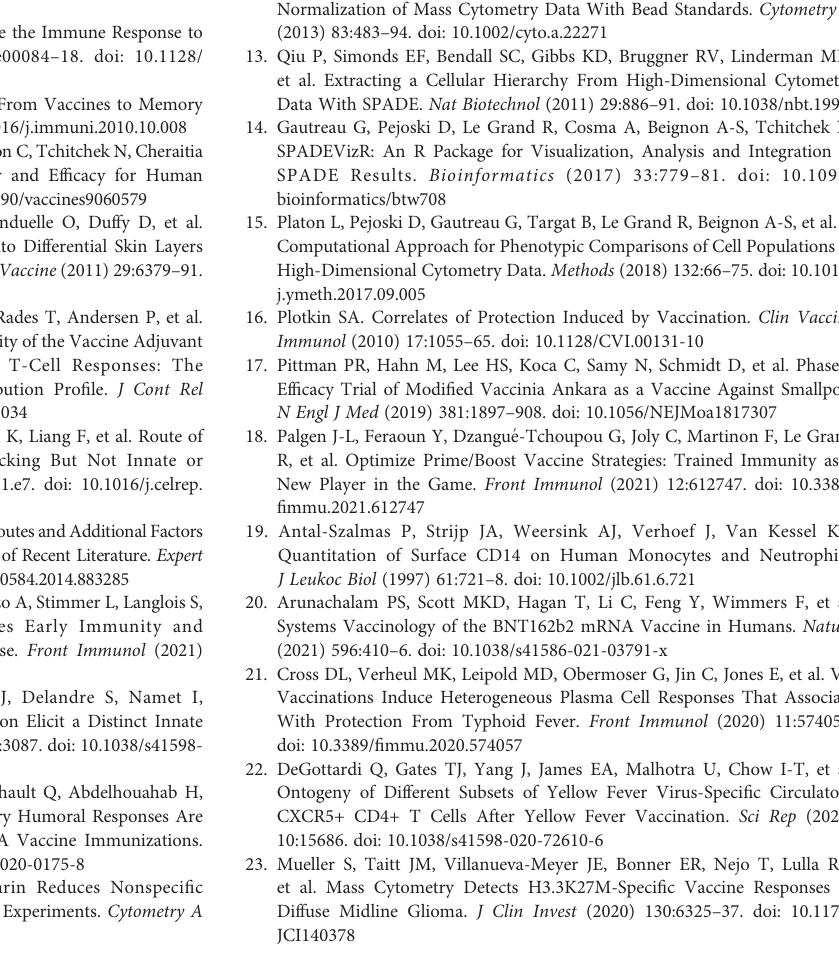
Supplementary Figure S1 | Control samples. The same fi xed and frozen control samples were stained and acquired with the samples from the vaccinated animals after exvivo restimulationwithamixtureofTLRligands. (A) Gatingstrategytode fi ne the CD66 high HLA-DR - , CD66 -/mid HLA-DR -, and CD66 -/mid HLADR + cell populations. The non-stimulated control sample for the fi rst staining/acquisition session is shown. (B) Comparison of the staining pro fi les using overlaid histograms. Supplementary Figure S2 | SPADE tree annotation. The topology of the SPADE tree is shown, with the color of each node of the SPADE tree representing the median expression of the indicated markers among all cells from the entire dataset with a scale adapted for each marker. This allowed the identi fi cation of the major blood cell populations, including granulocytes. The size of the node is not proportional to the number of cells it contains. Supplementary Figure S3 | Cytokine and chemokine expression pro fi les in blood after one or two ID MVA immunizations. The plasma concentration of 22 cytokines was measured before, 1 day, 7 days, and 14 days after one or two doses of MVA injected ID (n = 6). Areas under the curve (AUC) from H0 to D14 post- immunization were calculated to represent an approximation of exposure over time, in pg×ml -1 ×day. The mean AUC of each cytokine after the fi rst and second MVA ID injection is shown as a graph. Zero values are arbitrarily represented on the X axis. Statisticallysigni fi cantdifferences(p<0.05,Wilcoxontests)betweenthe1 st and2 nd injection are indicated by an asterisk (*). Supplementary Table S1 | Antibody panel for mass